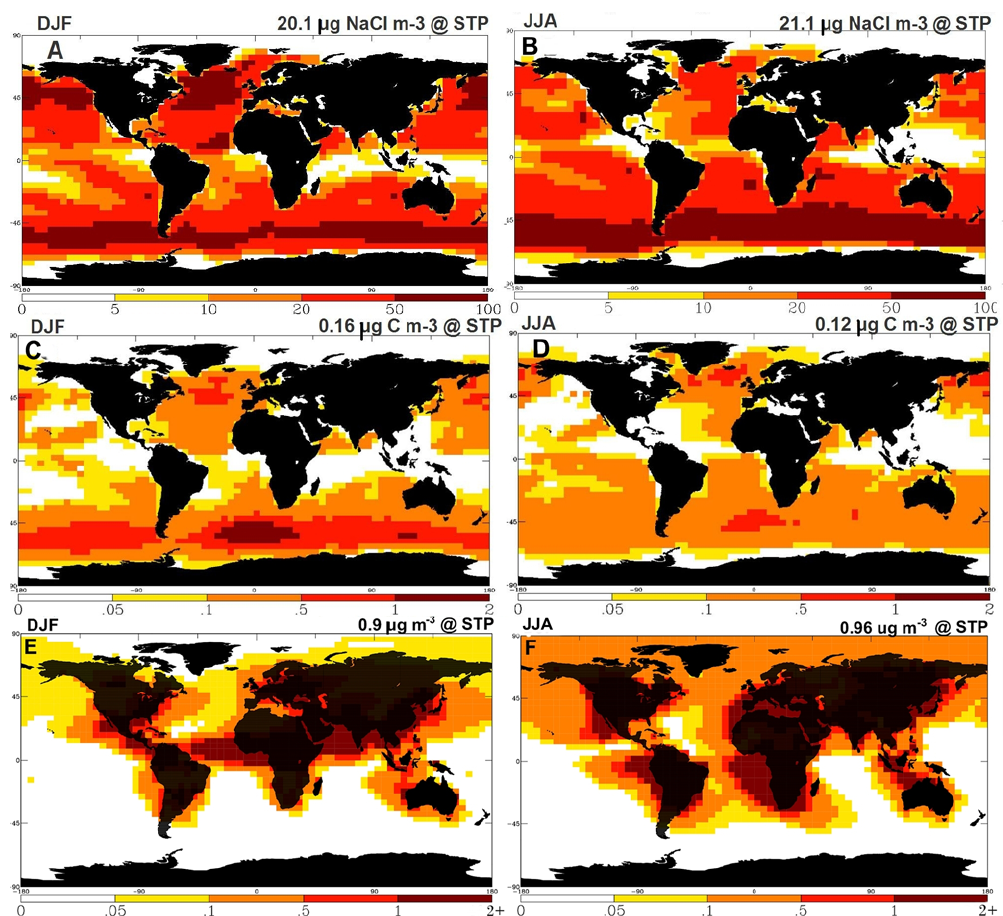
Fig. 1. Total sea salt (panels A and B ) and marine organic aerosol (panels C and D ) mass concentrations (in µgm − 3 ) at the surface for a three-month seasonal average over December, January, and February (panels A and C ), and June, July, and August (panels B and D ). For the same set of months, panels (E) and (F) show the surface mass concentrations of organic aerosol without the marine organic source function. Concentrations are calculated at a standard a temperature of 273K and pressure of